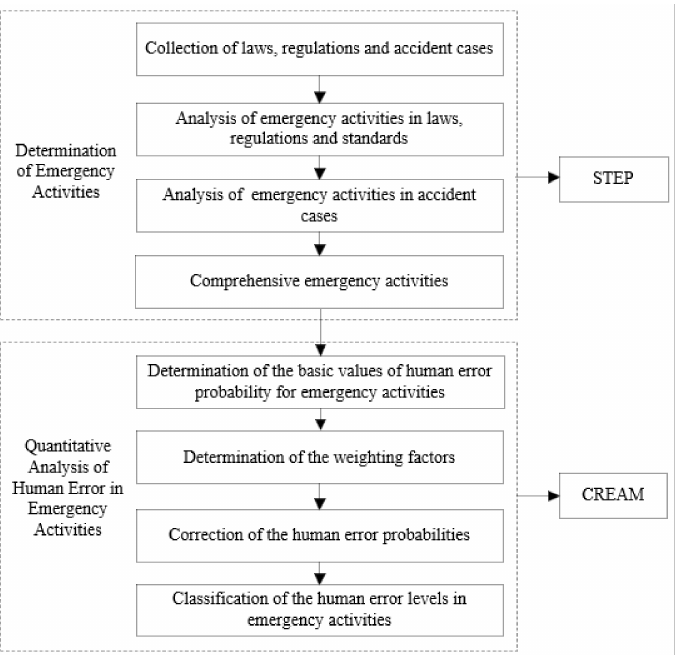
Figure 1. Combination of STEP and